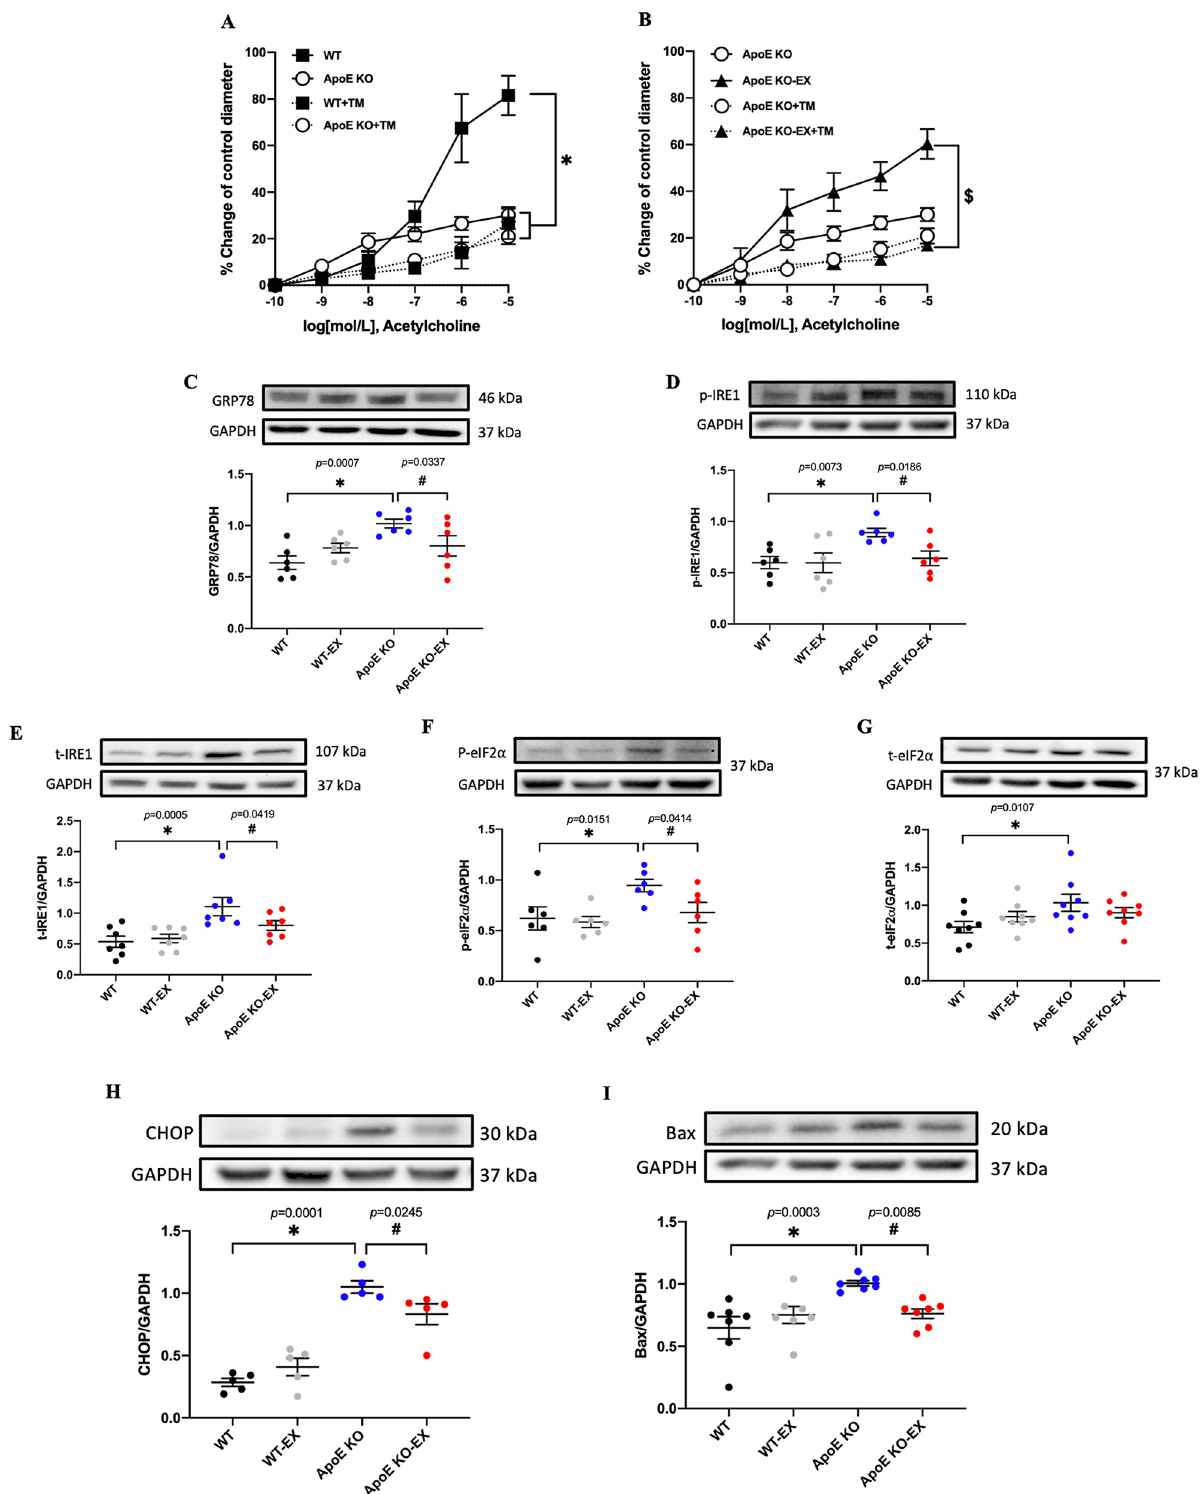
Figure 2. Effect of exercise training on ER stress-associated endothelial dysfunction in coronary arterioles and the expression of ER stress and apoptosis in the heart of ApoE KO mice. ( A – B ): ACh-induced vasodilation was measured in the presence of ER stress inducer (tunicamycin) from the isolated coronary arterioles in WT + TM (n = 4), WT-EX + TM (n = 4), ApoE KO + TM (n = 5), and ApoE KO-EX + TM (n = 4). ( C – H ): The protein expression of ER stress markers; GRP78 ( C ; n = 6/groups), p-IRE1 ( D ; n = 6/groups), t-IRE1 ( E ; n = 7/groups), p-eIF2α ( F ; n = 6/groups), t-eIF2α ( G ; n = 8/groups), CHOP ( H ; n = 5/groups), and pro-apoptotic marker, Bax ( I ; n = 7/groups) were analyzed by western blot. Values are presented as means ± SEM. * p < 0.05 versus WT, # p < 0.05 versus ApoE KO, § p < 0.05 versus ApoE